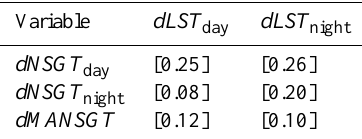
Table 4. Correlation of detrended remotely-sensed variables with detrended in-situ variables at the logger sites. Variables were de- trended by resting each variable’s linear trend with elevation. Spear- man correlation coefficients and tests, non-significant associations in square brackets; FDR controlled at ≤